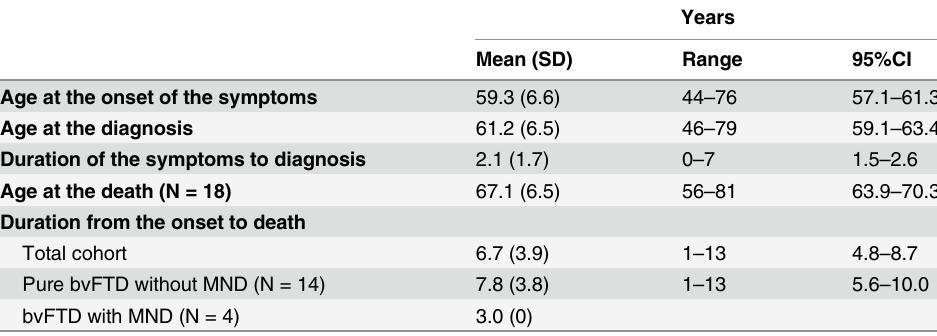
Table 1. Characteristics of the study participants.